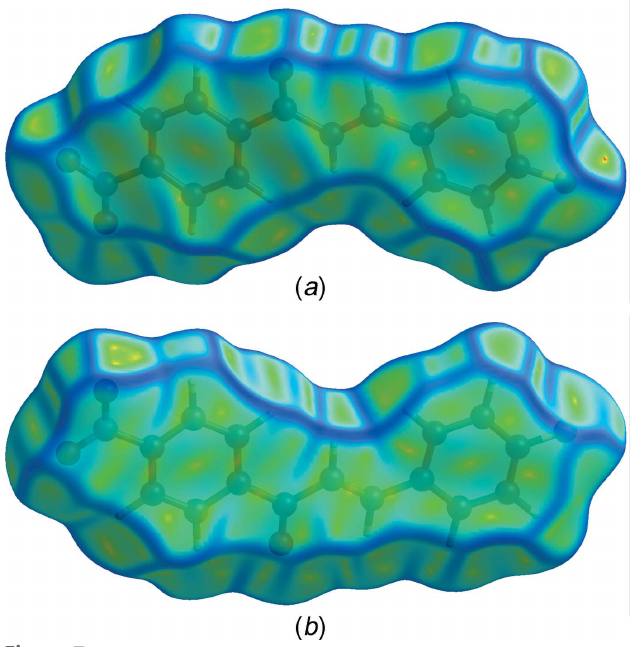
Figure 7 ( a ) Front and ( b ) rear views of the Hirshfeld surface mapped over curvedness.